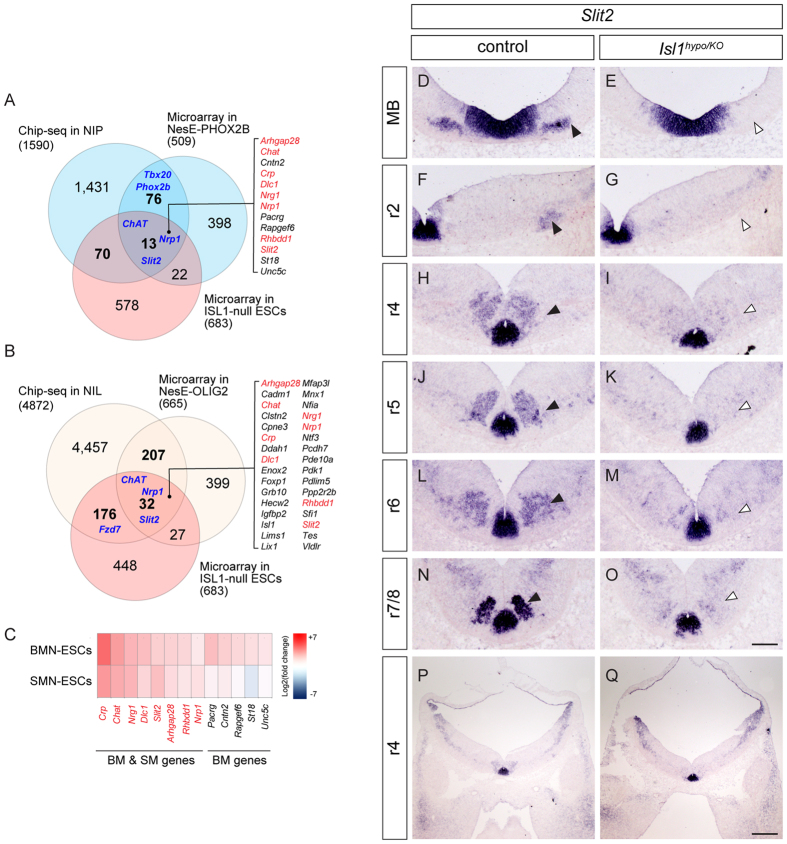
Reduced Slit2 transcripts in Isl1 mutant BMNs.(A,B) Venn diagrams indicating the overlap between ISL1 binding sites in a Chip-seq analysis and two independent microarray analyses in BM (A) and SM (B) cells. The list of genes found in both BM and SM cellular contexts is shown in red. (C) Heatmap of genes associated with BM and SM neurons. Red indicates higher relative expression, and blue indicates lower relative expression compared to the median values of the two groups. (D–Q) At E11.5, Slit2 mRNA is undetectable in oculomotor (E), trigeminal (G), facial (I,K,M) and SM (O) neurons (white arrowheads) unlike their littermate controls (black arrowheads, D,F,H,J,L,N). (control: n = 3; Isl1 mutant: n = 3; number of embryos). Scale bars: in (O), 100 μm for (D–O); in (Q), 200 μm for (P,Q).